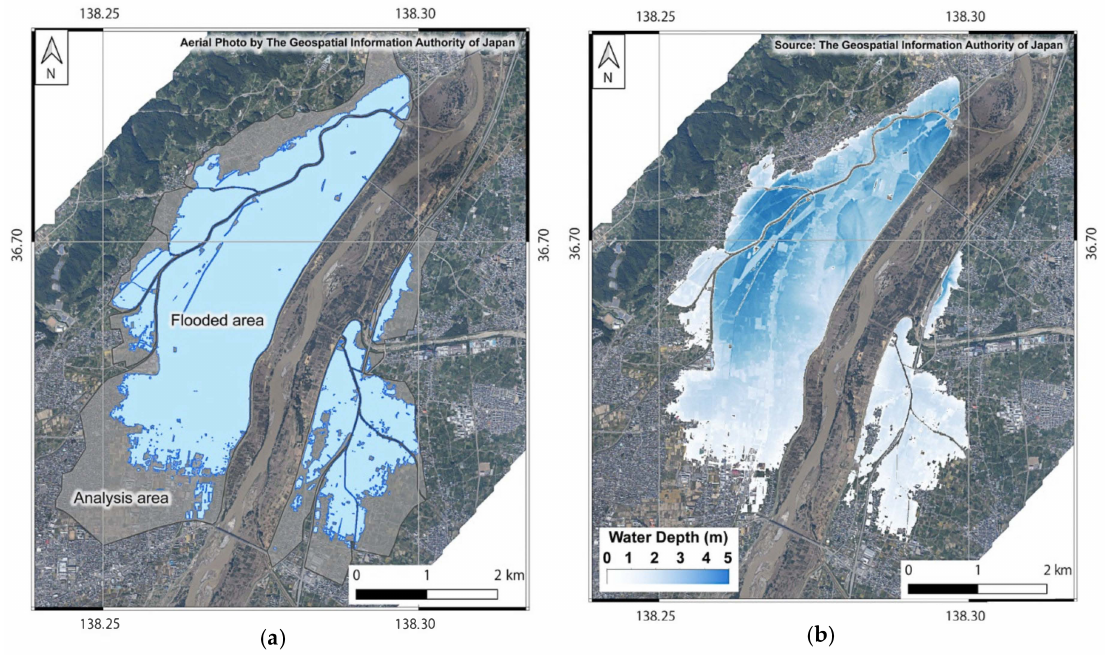
Figure 4. Ground truth data of the close-up area: ( a ) analysis area and ( b ) water depth (0–5